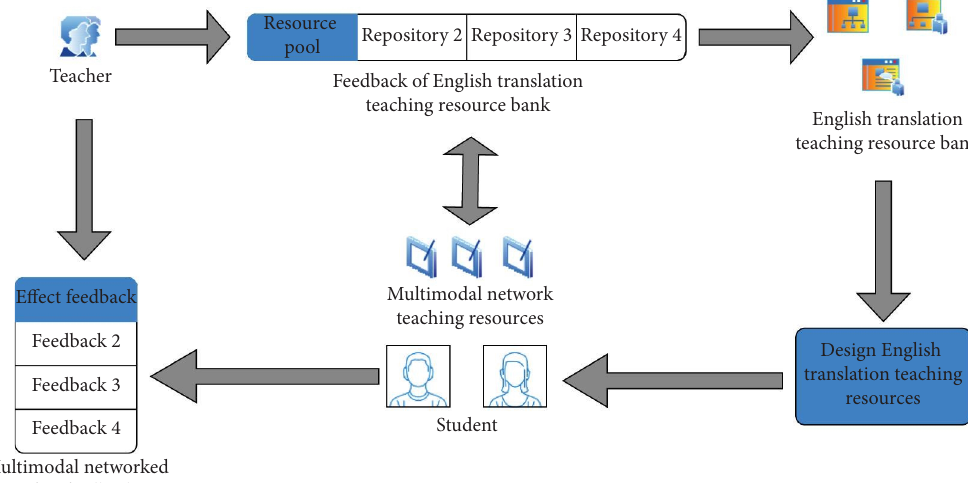
Figure 1: Relationship between multimodal networking and the main body of English translation skills resource